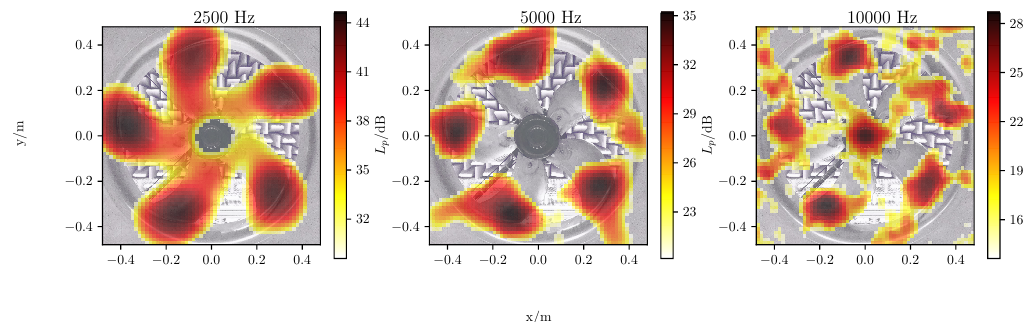
Figure 10. One-third octave band source maps for 2.5, 5 and 10 kHz obtained with the spiral array and cubic radial basis function interpolation between the microphones using conventional beamforming.